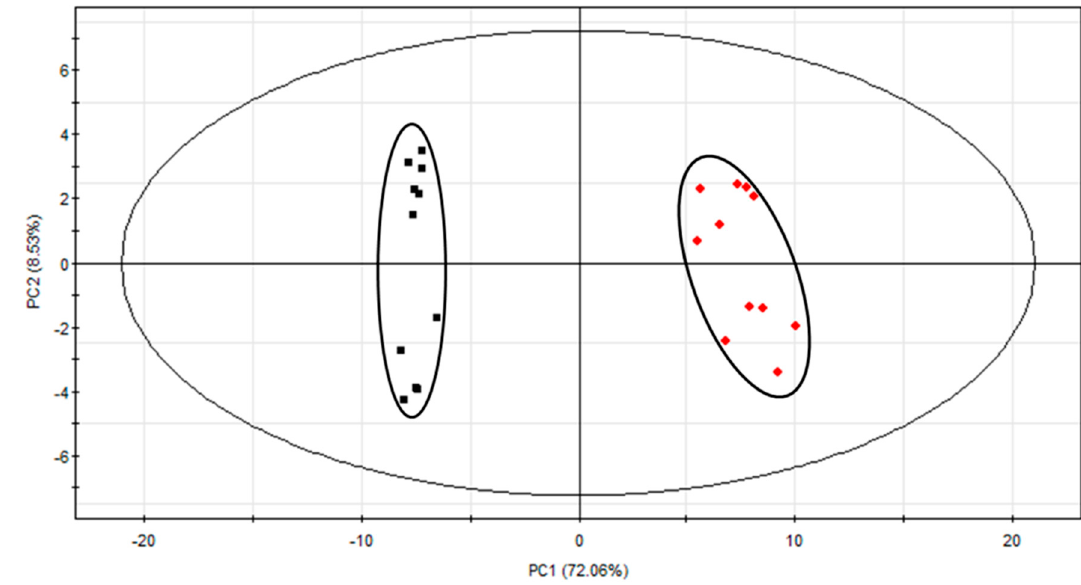
Figure 2. Principal component analysis (PCA) score plots based on gas chromatography-mass spectrometry (GC-MS) data of SS (black) and SSC (red).